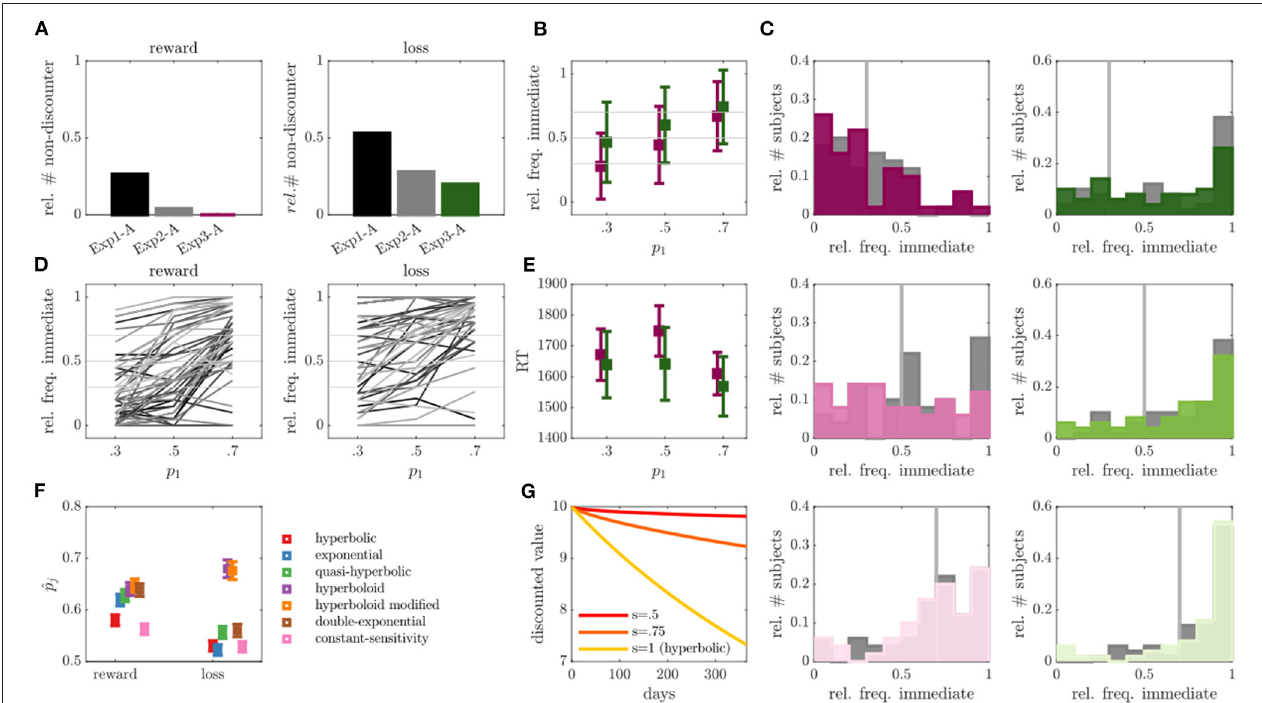
FIGURE 4 | Results of experiment 3. (A) Relative number of non-discounter in run A across experiments for reward (left) and loss (right) conditions. (B) Relative frequency of immediate choices ( y -axis) in run B of exp 3 as a function of experimentally manipulated probabilities ( x -axis) for reward (magenta) and loss (green) conditions (individuals without behavioral variability were removed, N = 0 for reward, N = 10 for loss condition). (C) Empirical distributions of the relative frequency of immediate choices in run B for trials with immediate choice probability 0.3 (top), 0.5 (middle) and 0.7 (bottom), as also indicated by the gray line. Reward condition is displayed left, loss right, exp 2 in gray and exp 3 in color. (D) Average relative frequencies of immediate choices per subject across the three experimentally manipulated immediate choice probabilities. (E) Average over median reaction times (RT) for the three experimentally manipulated immediate choice probabilities for reward (magenta) and loss (green) conditions. (F) Average predicted (out-of-sample) probability of observed responses ˆ p j ( y -axis) for reward and loss conditions ( x -axis) for different models averaged over run A and B. (G) Hypothetical discounting curves in the modified hyperboloid model for κ = 0.01, r 1 = 10, and different values of scaling parameter s